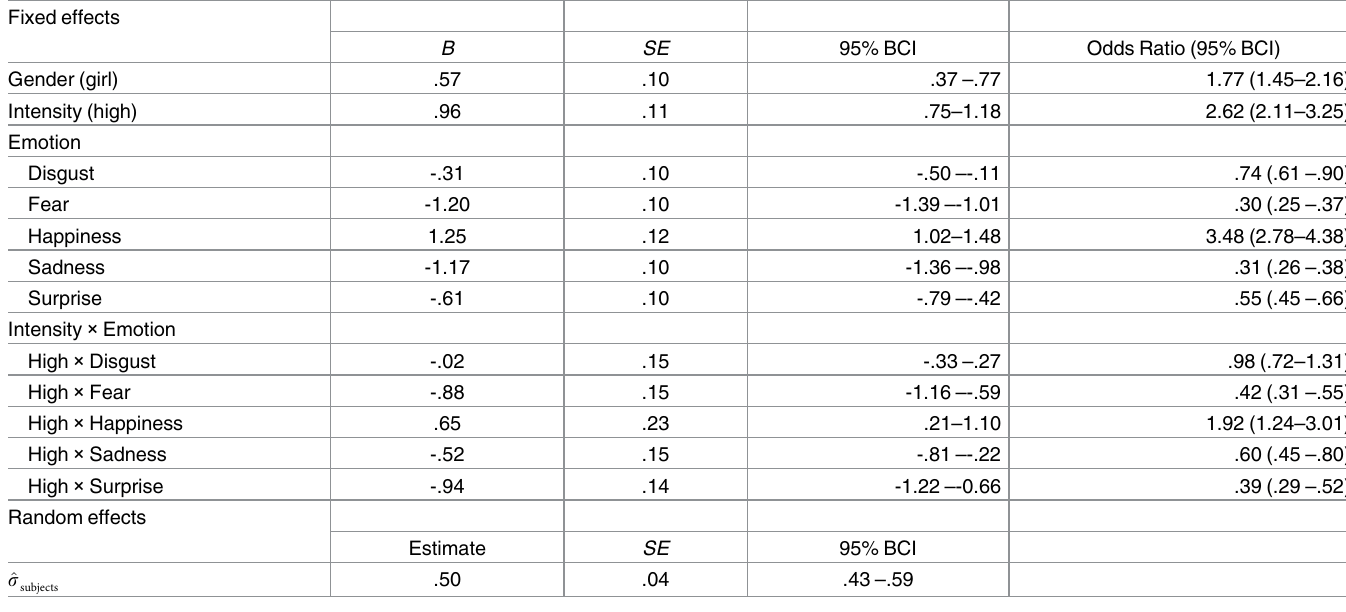
Table 2. Estimated parameters of the best fitting Bayesianlogistic mixed-effects model with accuracyin emotion recognition as dependent vari- able (M3). Fixed